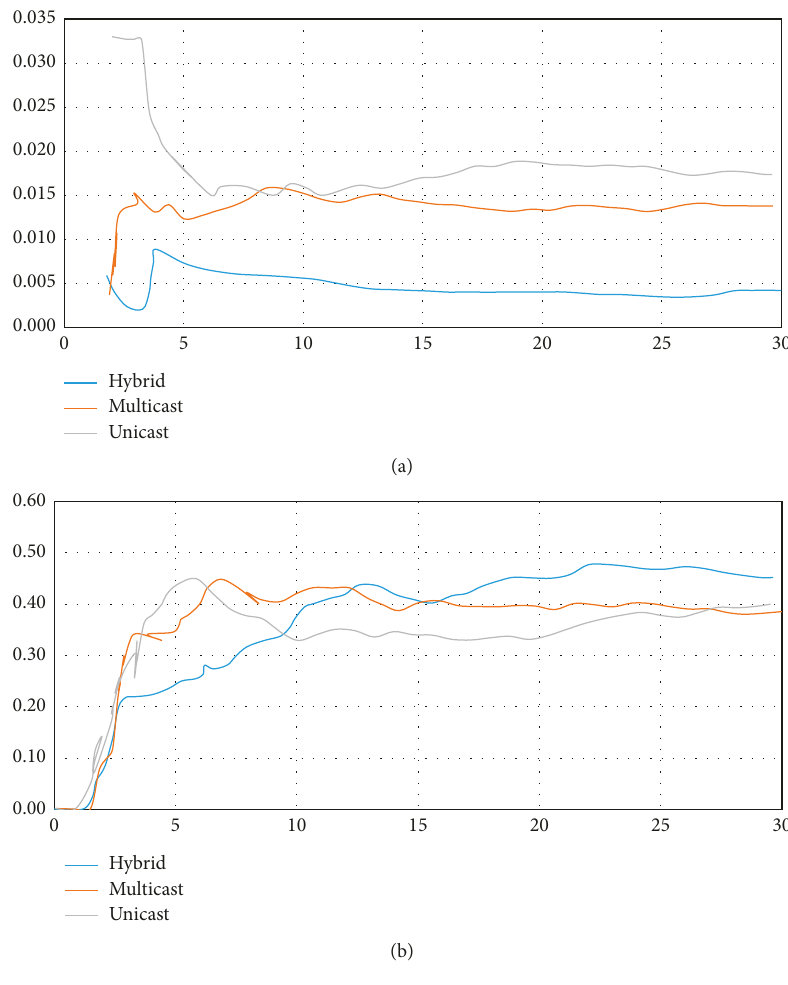
Figure 7: (a) Processing time. (b) Traffic request.